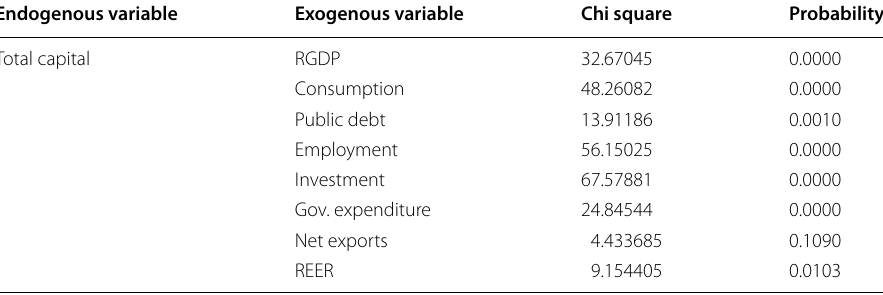
Table 7 Wald test results for Eq. (3). Source : Author’s calculations